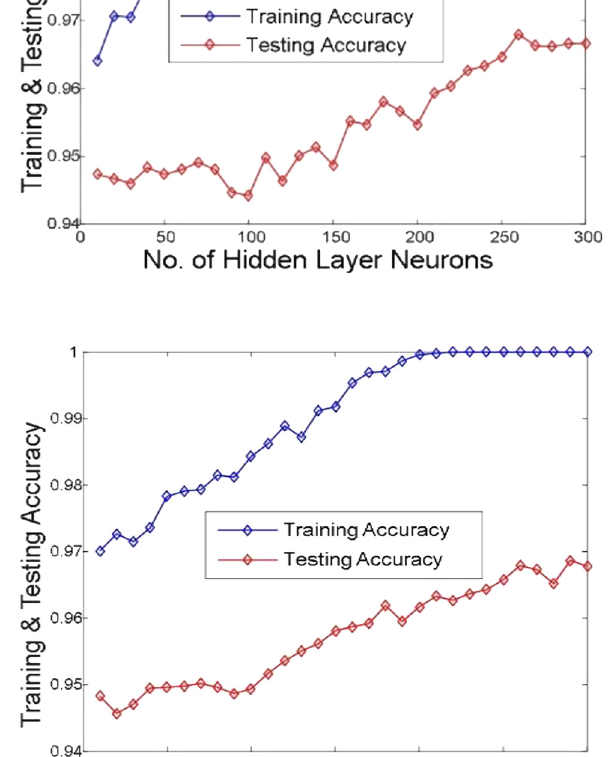
Figure 9: Hidden neurons versus training & testing accuracy (CJaya-ELM).